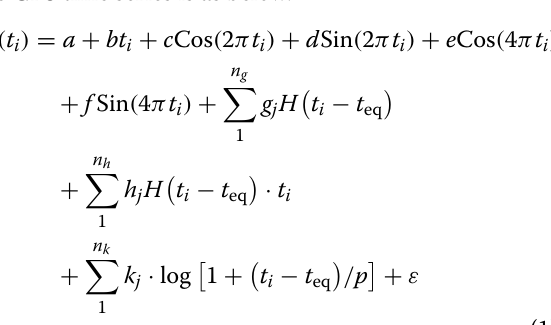
a Chengkung and Taitung earthquakes are 2003.93852 and 2006.24454, respectively